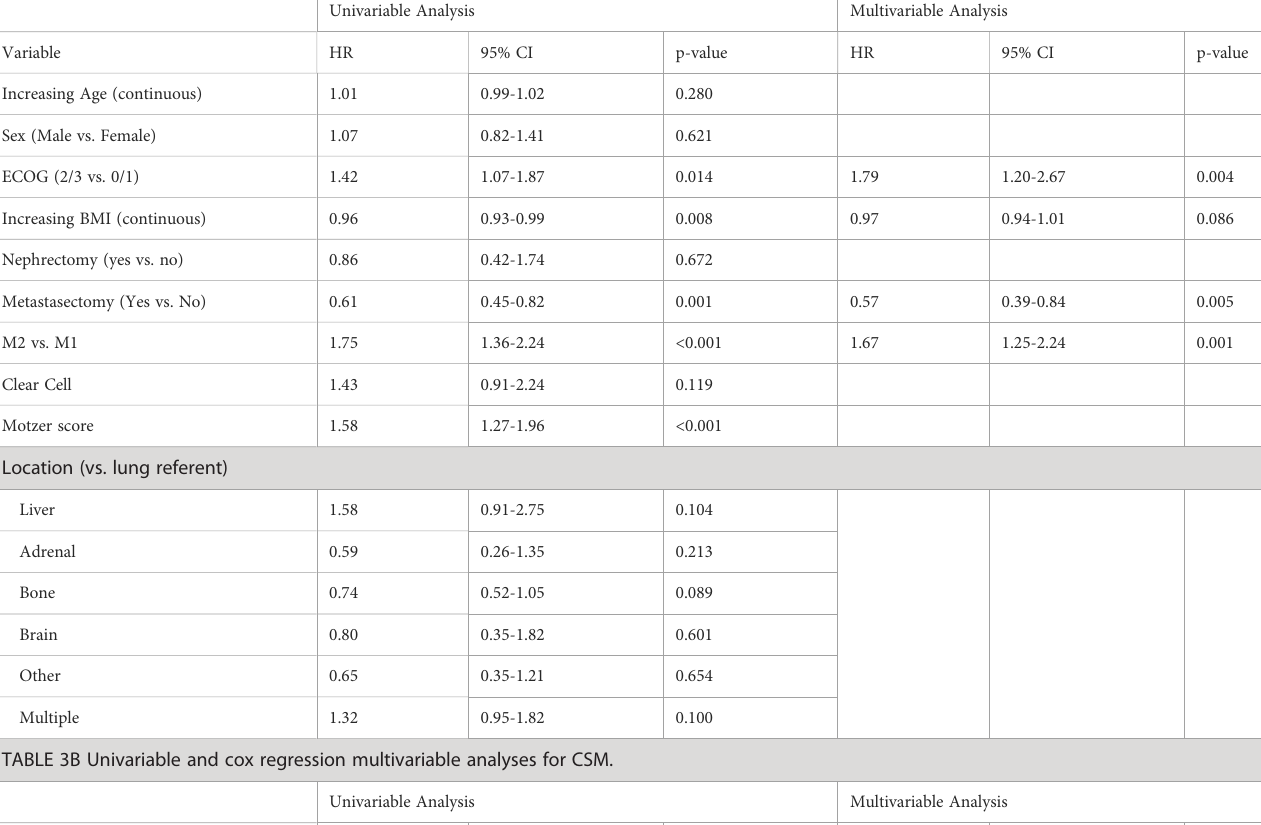
TABLE 3 Univariable and multivariable analyses. TABLE 3A Univariable and cox regression multivariable analysis for ACM.